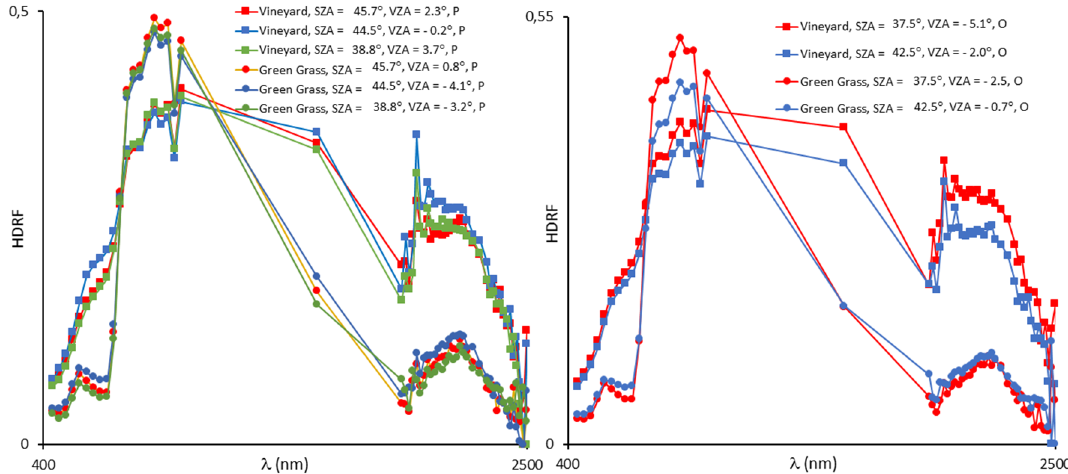
Figure 7. Airborne HDRF as a function of wavelength at the green grass and vineyard sites. P = flights parallel to the solar principal plane; O = flights orthogonal to the solar principal plane. The Solar Zenith Angle and the View Zenith Angle are indicated. P flight identifications: red solid square and circle (9:02 UTC, 25 July), blue solid square and circle (9:09 UTC, 26 July), green solid square and circle (9:40 UTC, 26 July). O flight identifications: red solid square and circle (9:46 UTC, 25 July), blue solid square and circle (9:19 UTC, 26 July).